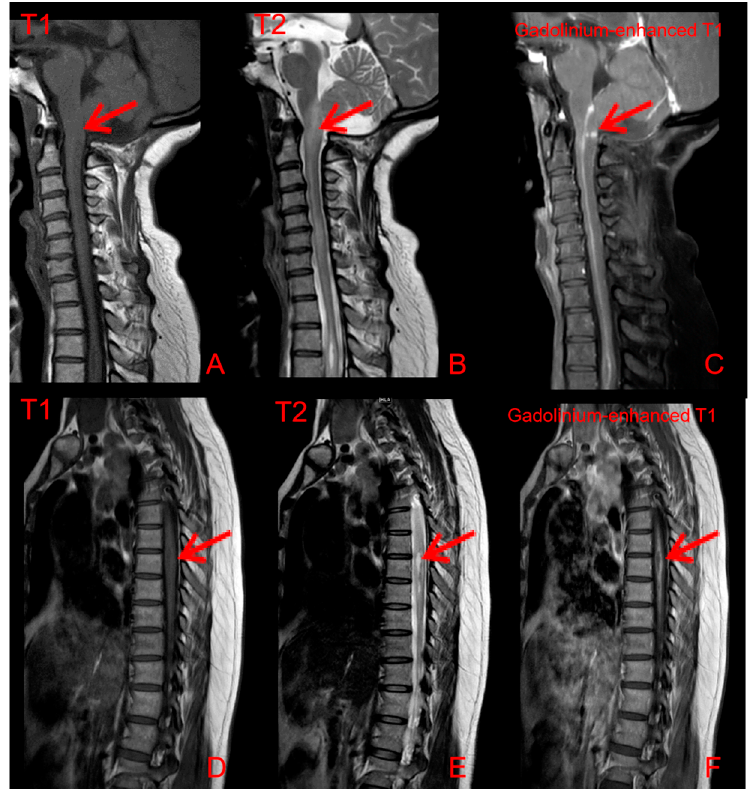
Figure 5. MRI of the spinal cord shows ( A ) hypointensity T1 signal and ( B ) hyperintensity T2 strips lesions below the level of the medulla oblongata, with slight thickening and swelling of the spinal cord. ( C ) Gadolinium-enhanced T1 MRI shows the line-like and nodular enhancement lesions at the level of C1 (SE 601A; IM 6), about 3 mm. ( D ) T1 phase, ( E ) T2 phase, and ( F ) gadolinium-enhanced T1 MRI shows the syringomyelia at the T3-4 level. Table 1. Data of neuroimmune parameters.